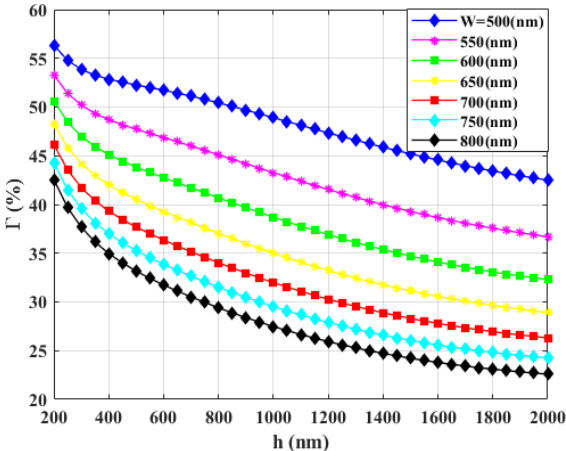
Figure 3. The confinement factor ( (cid:48) ) as a function of slot height ( h ) for different slot widths ( w